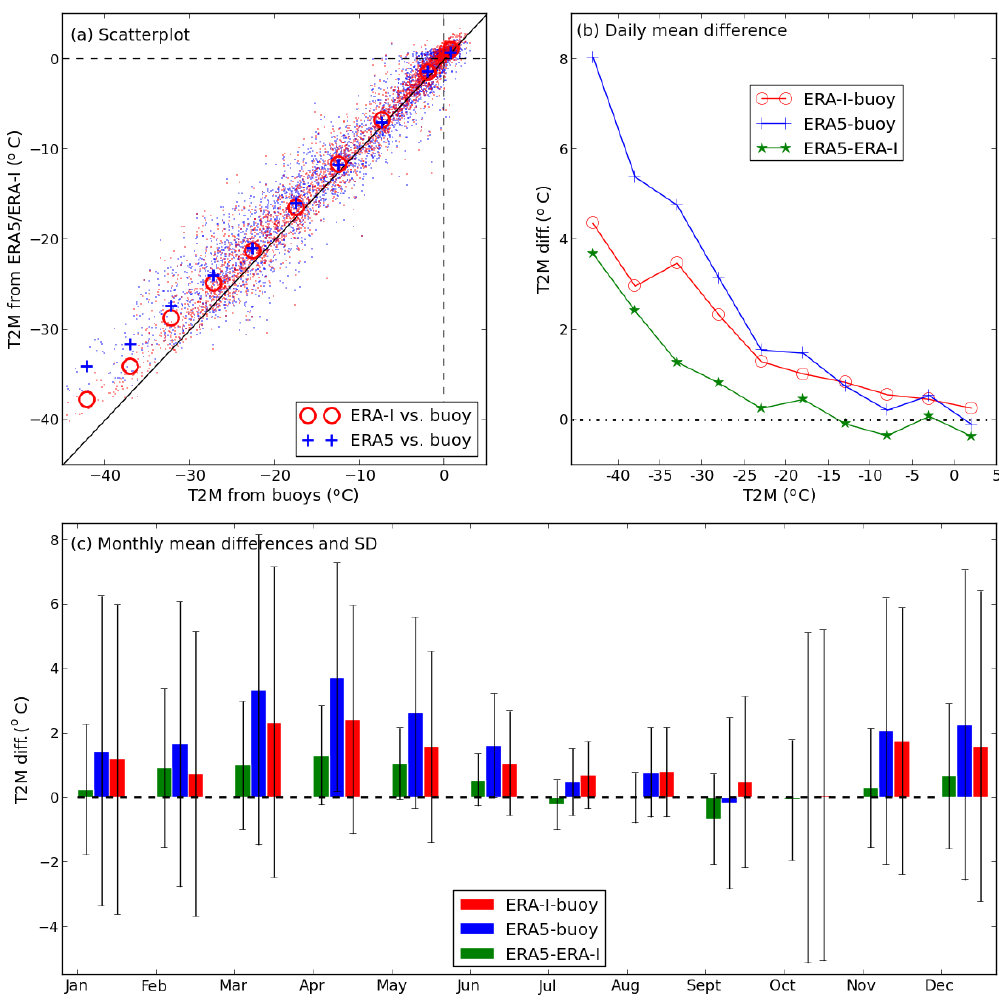
Figure 5. Statistics of T2M from ERA5, ERA-I and all the buoys. (a) Scatter plot for all data (small dots) and average T2M at 5 ◦ bins between − 45 and + 5 ◦ C, (b) daily temperature differences between the reanalysis and between the reanalysis and the buoys corresponding to 5 ◦ bins between − 45 and + 5 ◦ C, and (c) monthly mean differences and standard deviation (SD). In panel (a) , the black solid line is for